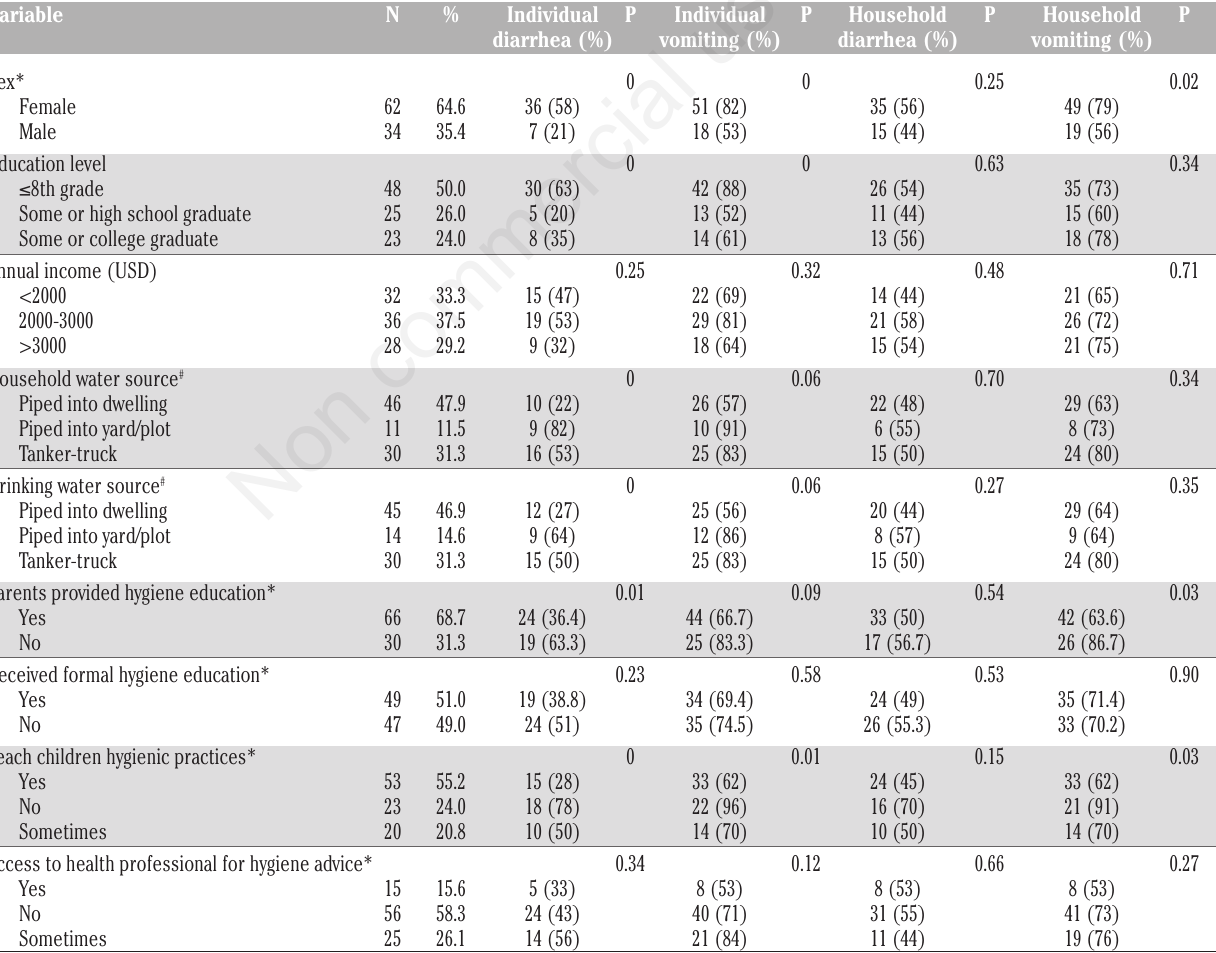
Table 2. Total distribution of demographic and water/personal hygiene practice variables of interest and distribution of these same vari- ables across individual and household gastrointestinal cases (case is defined as having 2 or more episodes of diarrheal and emesis;